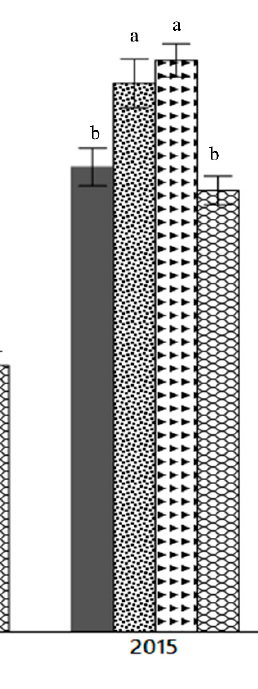
Figure 3. The long-term effect of tillage on the boron concentration in wheat straw under winter wheat–dry pea rotation. Bars sharing the same letter are not significantly different at 5% probability level. Error bars represent standard error of the least square mean.